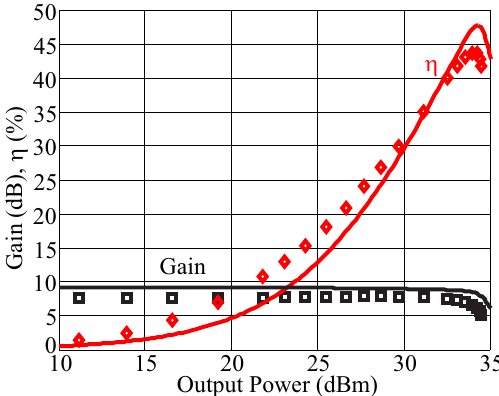
Figure 12. Power sweeps at 15 GHz of the class AB MMIC. Drain bias voltage and current are 30 V and 30 mA, respectively. Simulations: solid lines; measurements: symbols. Gain: black squares, efficiency: red